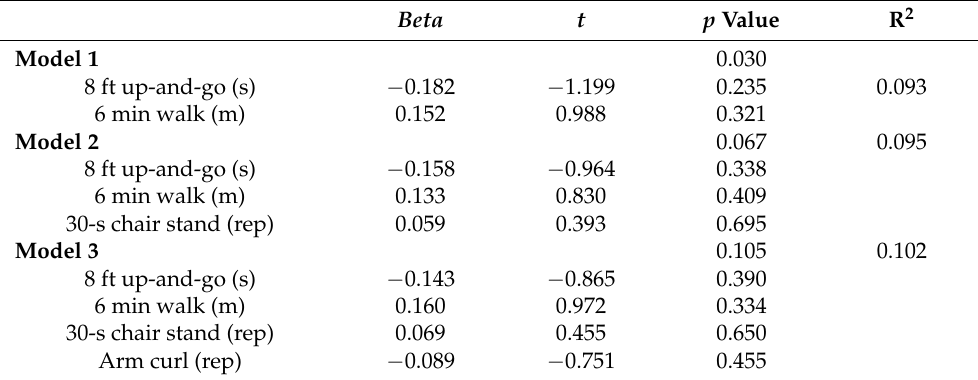
Table 5. Multiple linear regression (backward stepwise). Phase angle as a predictor for physical function. Only women.